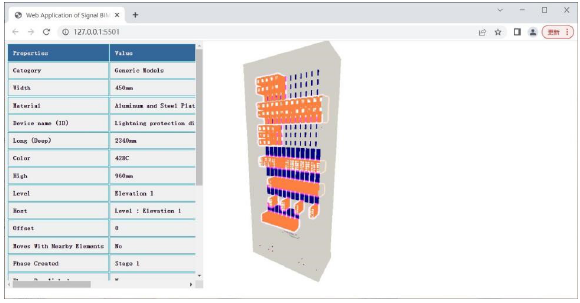
Fig. 12. Display of model attribute